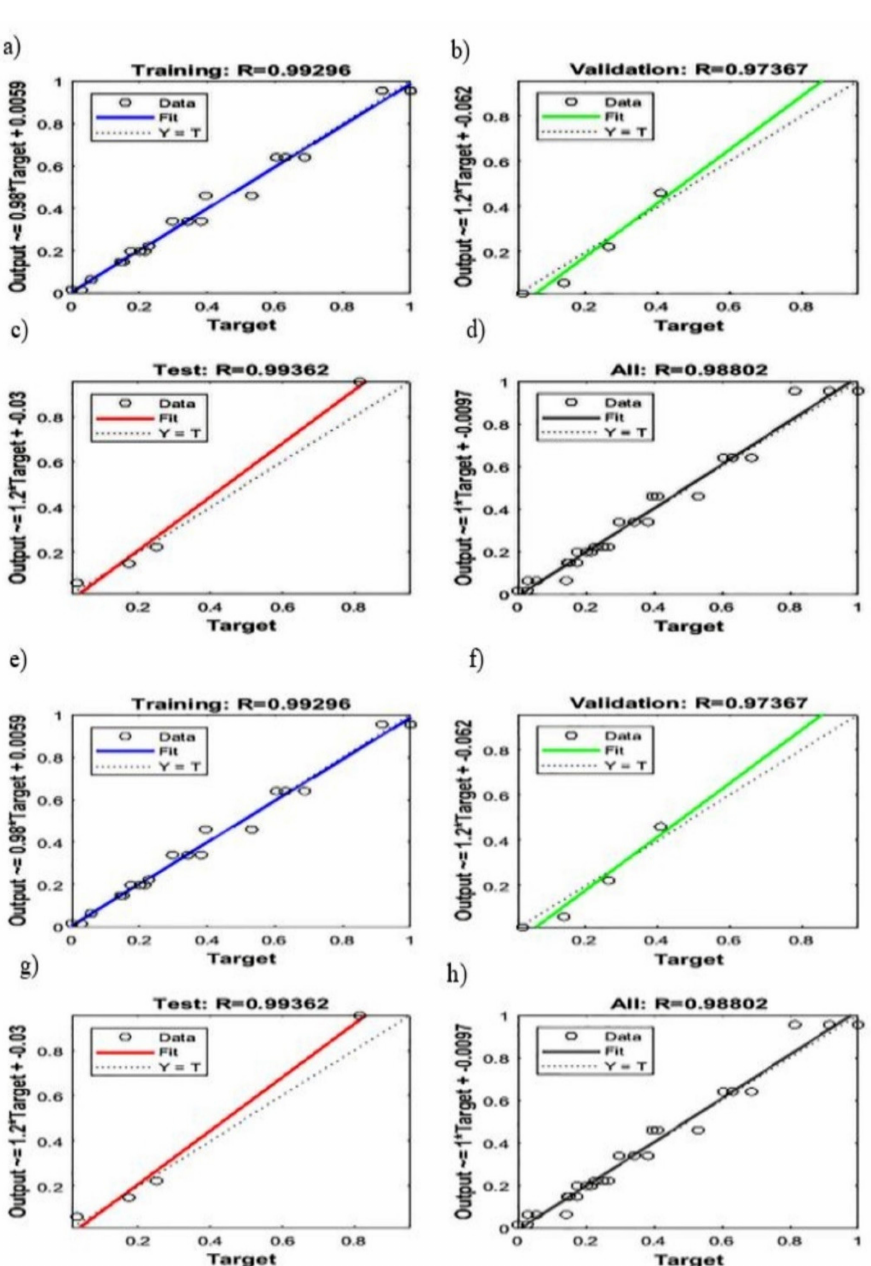
Figure 12. Regression plots for the fracture strength modeled by ANN (( a ): training, ( b ): validation, ( c ): testing, ( d ): average) and the yield strength of the developed nanobiocomposites modeled by ANN (( e ): training, ( f ): validation, ( g ): testing, ( h ):